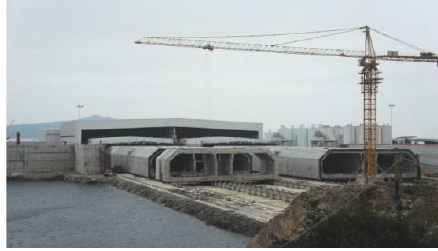
Figure 2: Fabrication of HZM